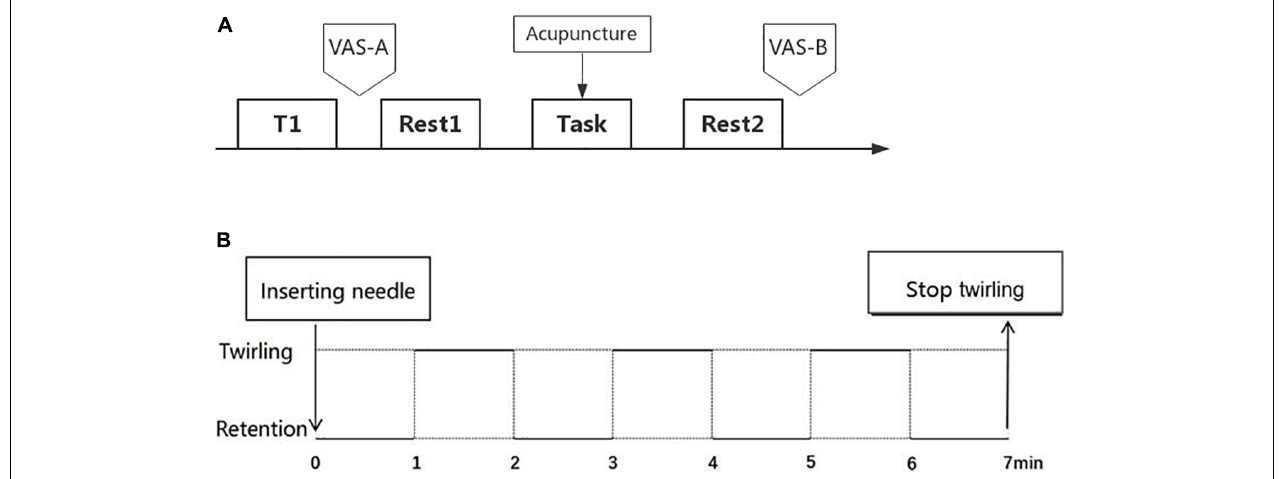
FIGURE 1 | Schematic diagram of the fMRI experimental process. (A) Structural-image scan (T1), function-image scan (rest1, rest2, and task), the paradigm of intervention (acupuncture), and evaluation of pain intensity (VAS-A and VAS-B). (B) In the task-state scanning, the acupuncture operation of the twirling and retention were performed alternately, with each condition for 1 min, and the total operating time lasted 7 min.